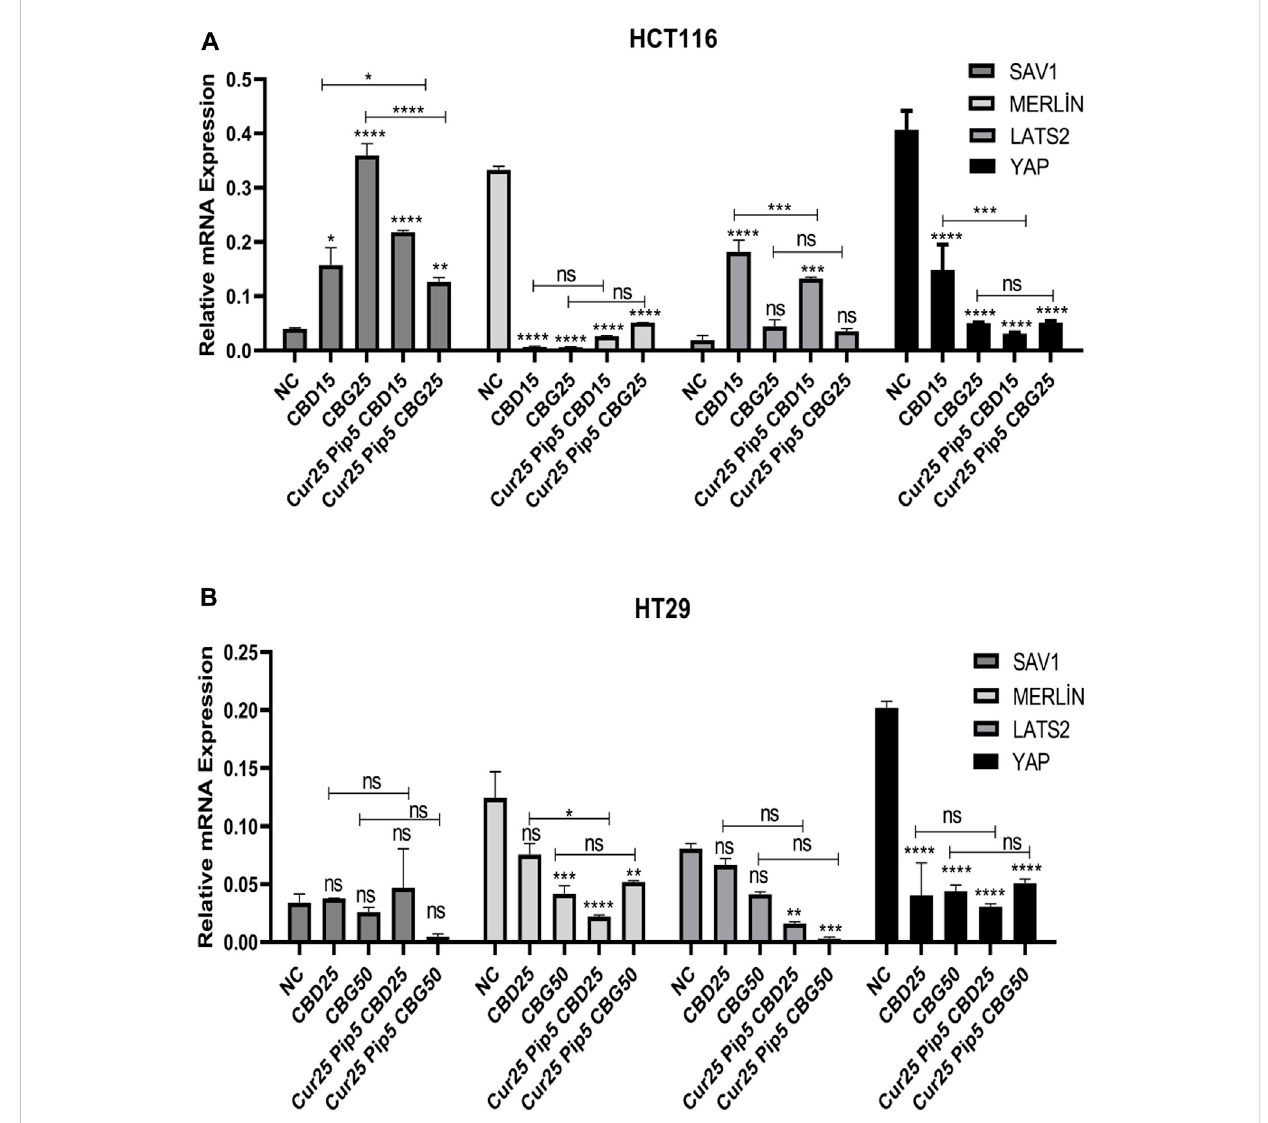
FIGURE 10 (A) Representative graph of Hippo pathway genes expression pro fi les of HCT116 cells after 72 h. (B) Hippo pathway genes expression pro fi les of HT29 cells after 72 h. (ns: non-signi fi cant, *: p < 0.05, **: p < 0.01, ***: p < 0.001, ****: p <